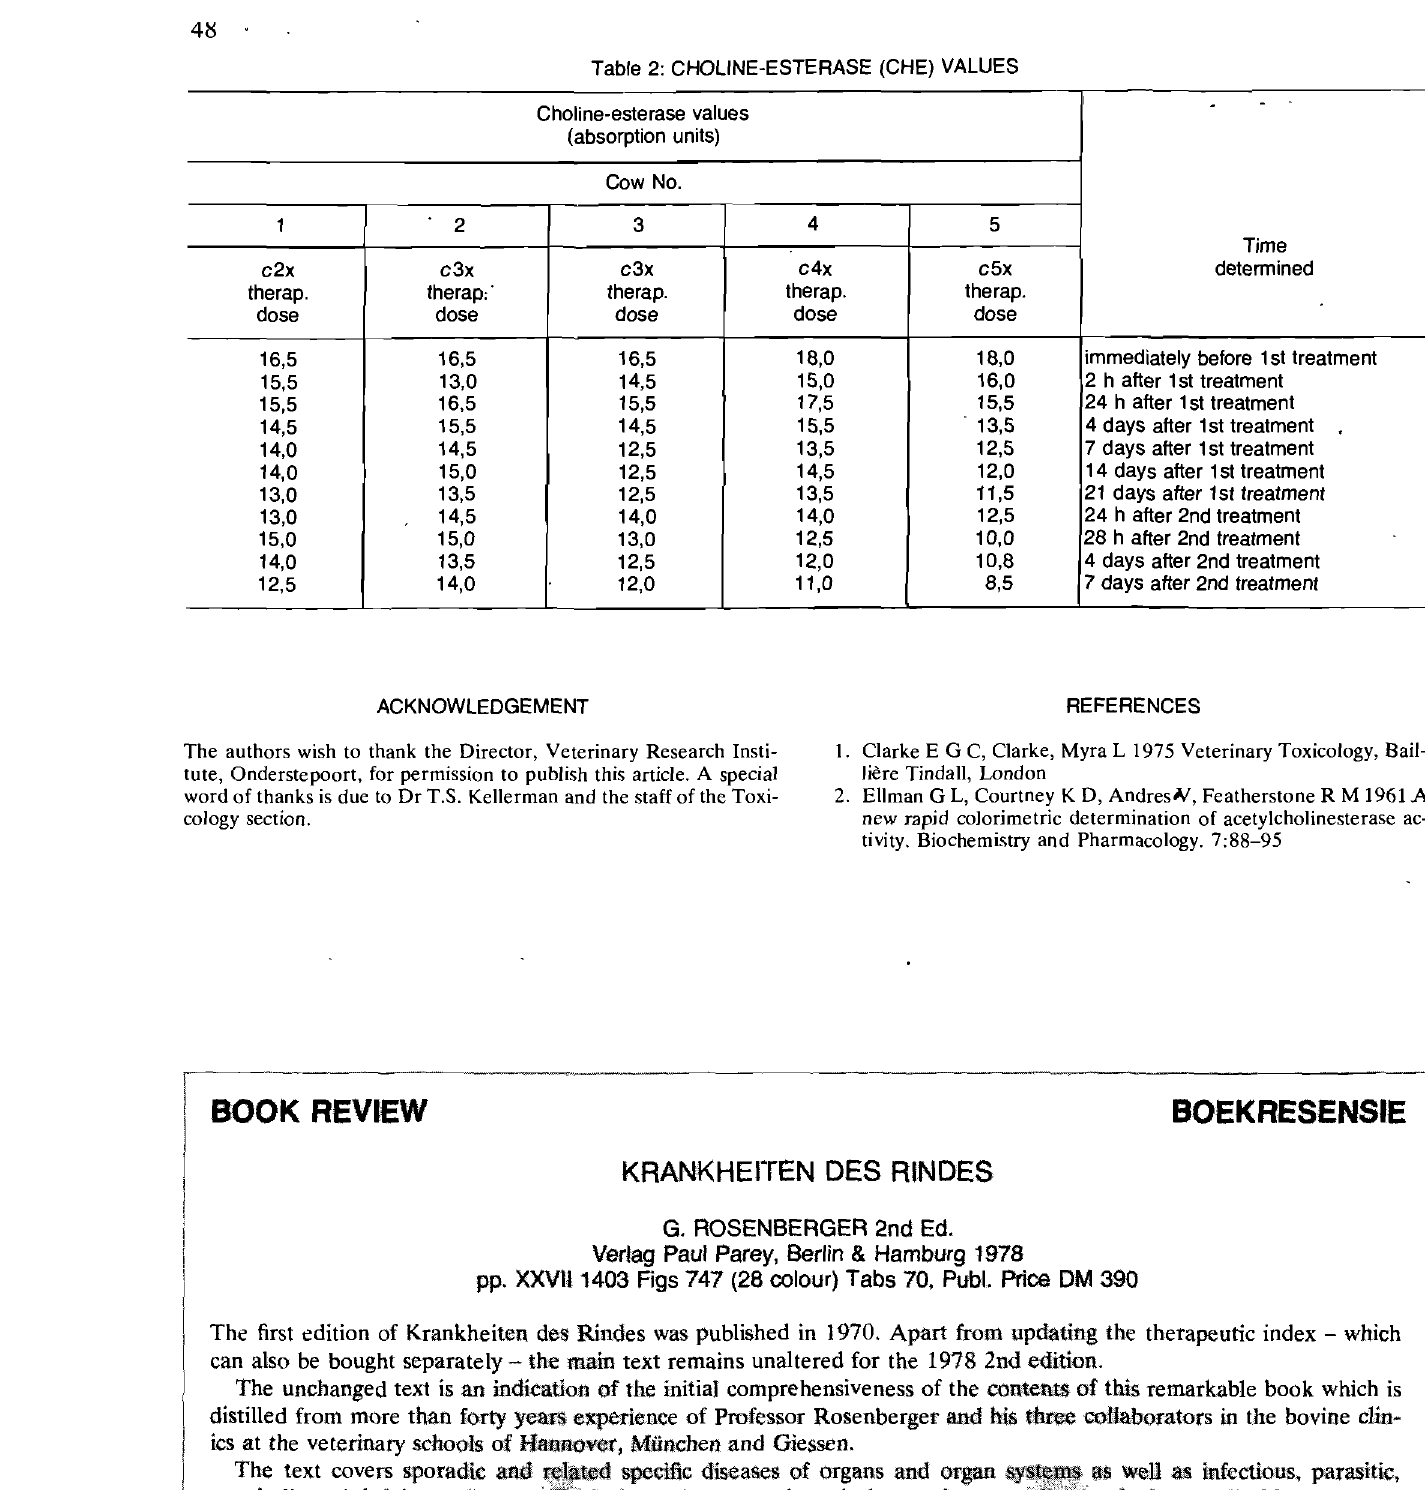
Table 2: CHOLINE-ESTERASE (CHE) VALUES Choline-esterase